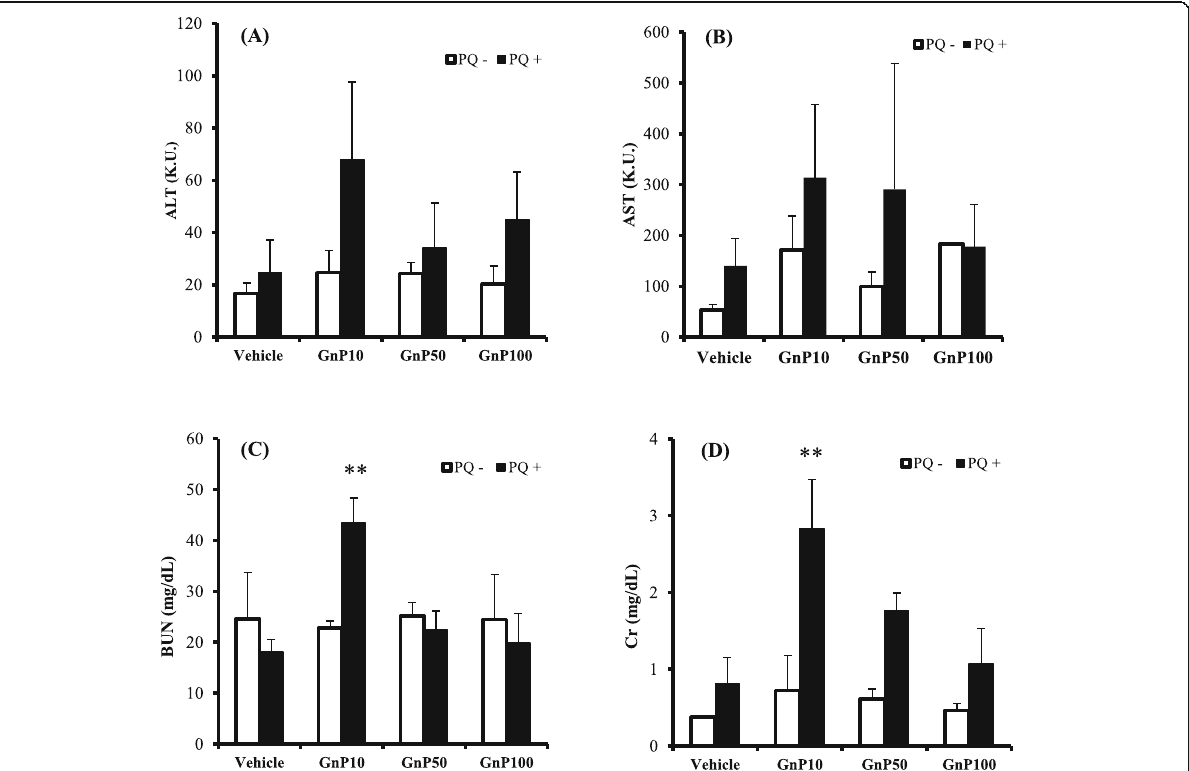
Fig. 4 Effect of gold nanoparticles on paraquat-induced toxicity. Mice were injected intraperitoneally with paraquat (PQ) at 0 (open bars) or 50 mg/kg (solid bars), together with an IV injection of vehicle or gold nanoparticles (4 mg/kg). At 24-h post-injection, serum levels of the liver enzymes alanine aminotransferase (ALT; a ) and aspartate aminotransferase (AST; b ), and plasma levels of blood urea nitrogen (BUN; c ) and creatinine (Cr; d ) were determined using commercially available kits (see “ Biochemical analyses ” section). Data are presented as mean ± standard error of the mean (SEM; n = 4). Significant difference (* P < 0.05, ** P < 0.01) between vehicle- and PQ-treated